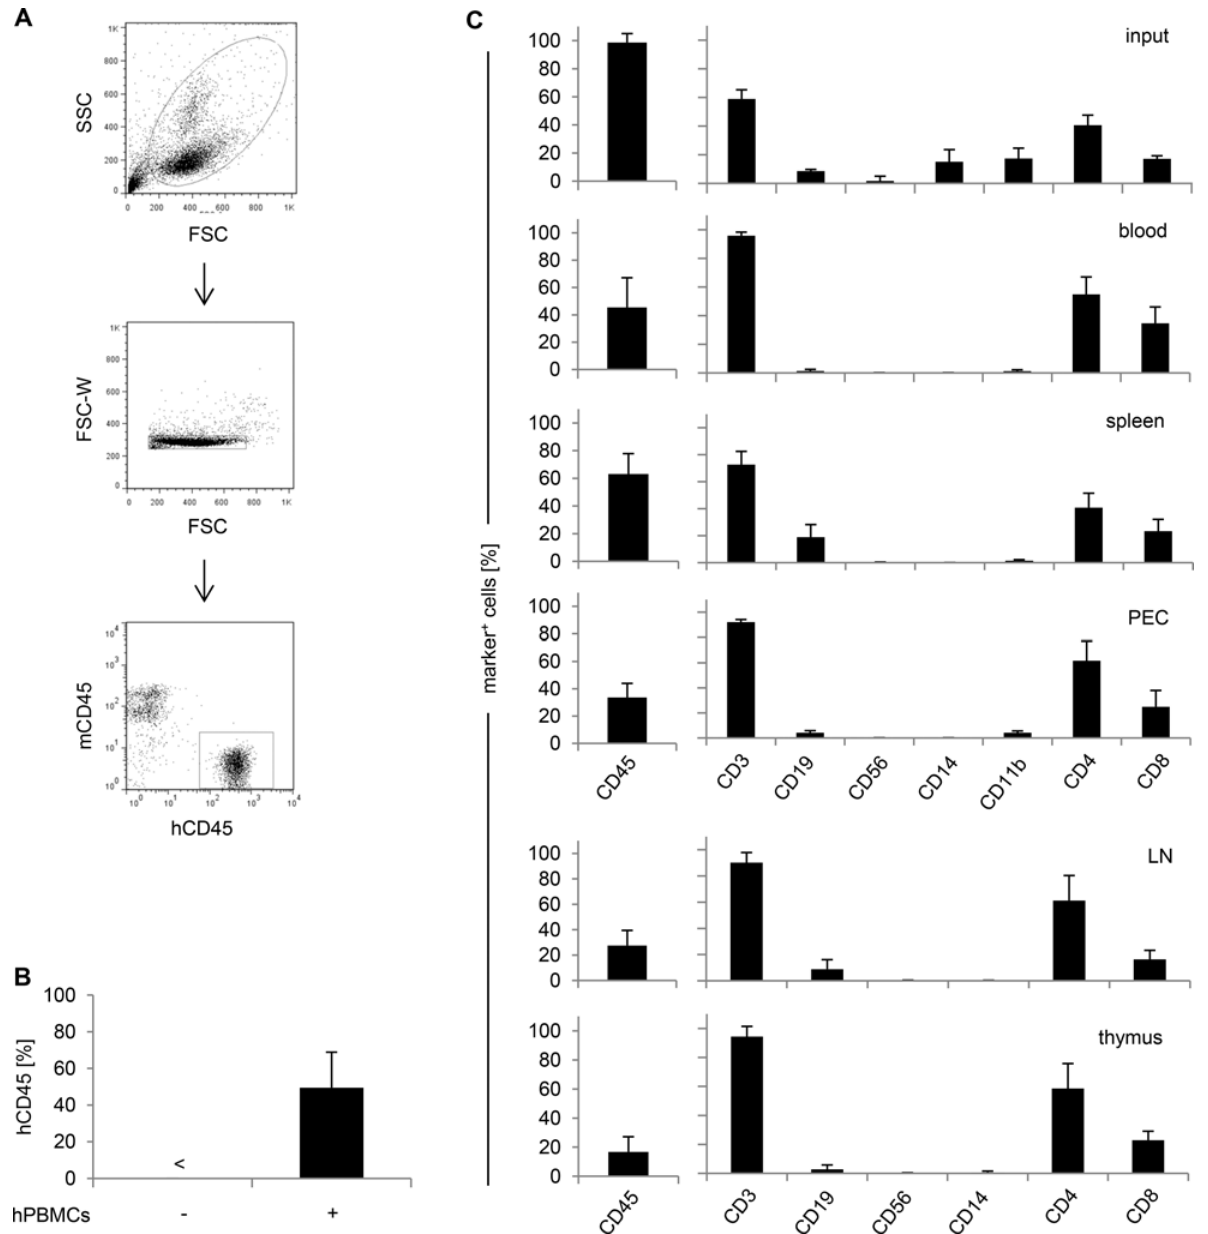
Fig 1. Human T cells are the predominant cell population within the peripheral blood in humanized mice. NRG mice were injected i.v. with 6.5x10 7 - 1x10 8 hPBMCs. (A) All flow cytometric analyses throughout this study were performed by gating on living cells in the FSC/SSC plot, excluding cell doublets in an FCS/FSC-W plot, and gating on hCD45 + cells. (B) Percentages of hCD45 + cells in the peripheral blood of NRG mice were analyzed by flow cytometric analysis before reconstitution (n = 3) or on day 8 – 16 after reconstitution (n = 73). < ; not detectable. (C) Cell composition within hCD45 + cells of freshly isolated hPBMCs (input; n = 6) or peripheral blood (n = 54), spleen (n = 14), PEC (n = 6), LN (n = 9), and thymus (n = 9) of humanized mice on day 8 – 16 after repopulation was analyzed by flow cytometric analysis. Data shown in (A) are representative for all flow cytometric analyses performed throughout this study. Data shown in (B) are taken from 1 – 13 independent experiments. Data shown in (C) are taken from 2 – 7 independent